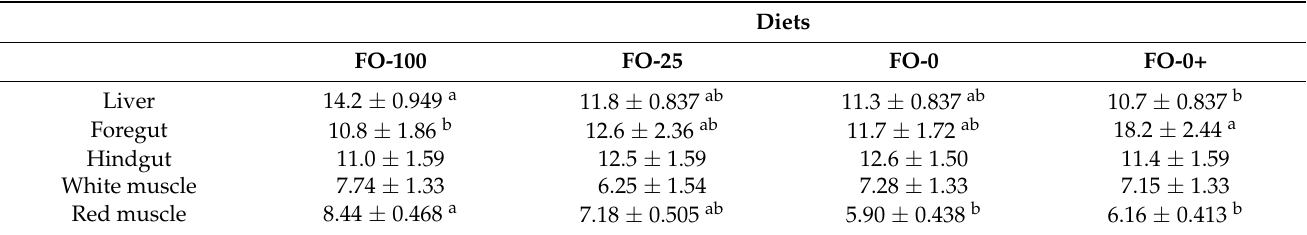
Values represent the mean ± standard error ( n = 9). Different superscript letters indicate significant differences between the treatments ( p < 0.05), Bonferroni